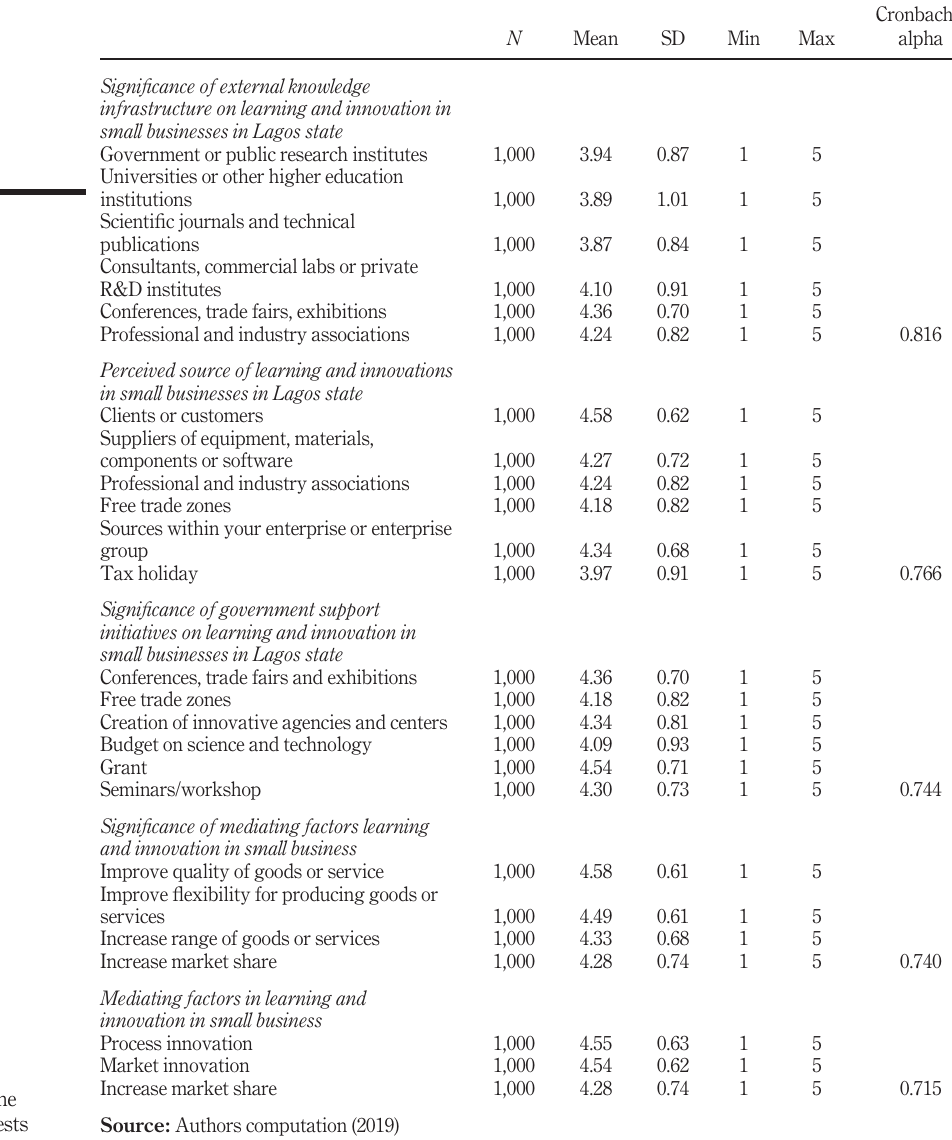
Table 4. Results of